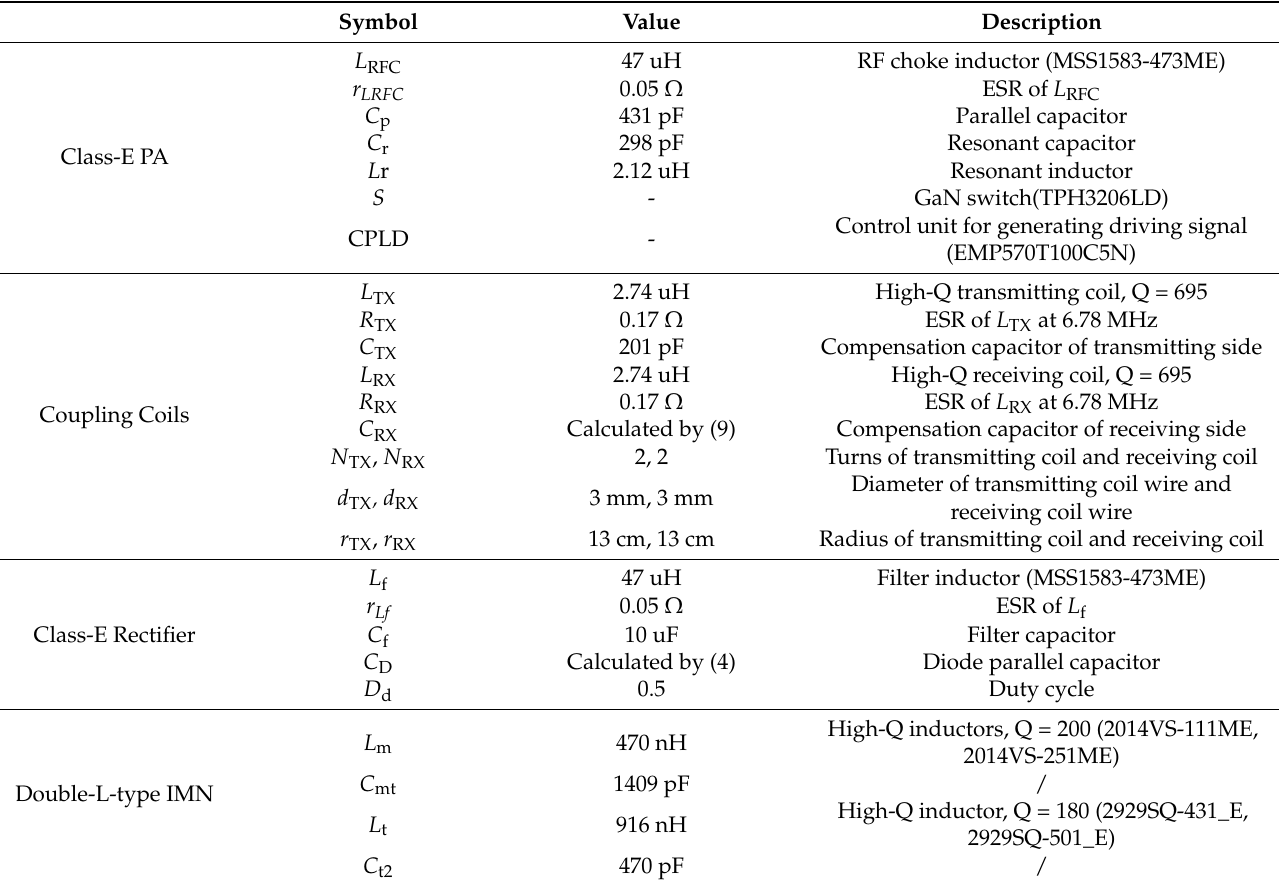
Table 1. Design parameters of Class-E2-based WPT